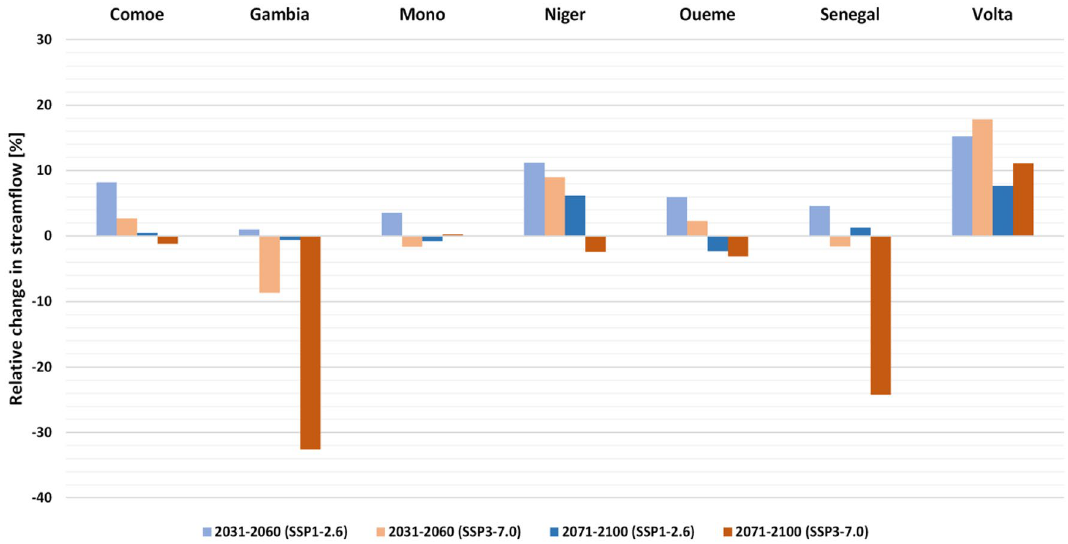
Figure 2. Changes in streamflow (%) relative to the 1981–2010 baseline for seven major river basins in West